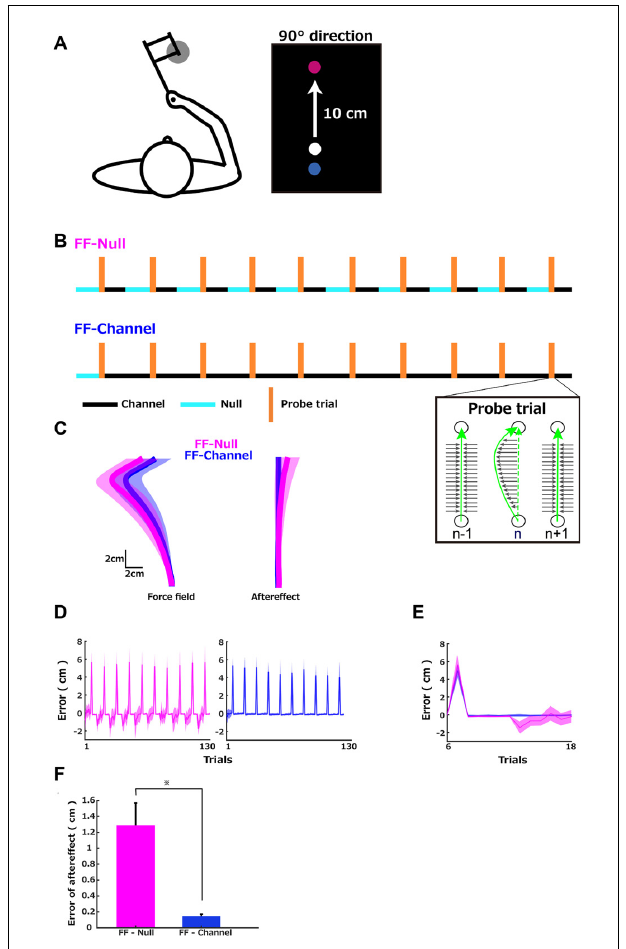
FIGURE 1 | Sequences of the force environments and errors. (A) Left: the configuration of the reaching task with the robotic manipulandum. Right 10 cm reach task. The red circle is the target position, and the blue circle is the start position. The white circle presented the cursor position. (B) Sequences of the force environments of the two groups. Three different force environments were presented to the participants: a zero-force environment (Null), a velocity-dependent curl force field (FF), and a channel-force (Channel) environment. In the error-clamp trials (TR), the stiff wall constrained the trajectory to a straight line and clamped any trajectory errors. The probe trials were composed of a first error-clamp trial, a force field (FF), and a second error-clamp trial. After five Null trials as familiarization, both groups performed 10 cycles of 13 trials composed of one probe trial, five error-clamp trials, and then five error-clamp (FF-Channel) or five Null (FF-Null) trials. (C) Group averages of the hand trajectories. Left: (1) average of the 10 FF trials computed for each participant and average (solid line) and standard deviation (shadow) across participants in each group (FF-Null in magenta and FF-Channel in blue). Right: (1) average of the 10 sets of each cycle’s last five trials and average and standard deviation across participants. (D) Each trial’s maximum trajectory errors were plotted over the FF-Null (left) learning trials and FF-Channel learning trials (right). The maximum error was defined as the maximum deviation from the straight line. (E) The average (solid line) and SD (shadow) across participants of each trajectory’s maximum deviation plotted over trials in the first cycle. (F) The aftereffect in the FF-Null (magenta) and FF-Channel (blue) conditions were captured by the maximum deviation at the first trial after the five error clamp trials following the probe trial. The error bar indicates the standard error. An asterisk indicates p < 0.05 by Mann–Whitney U